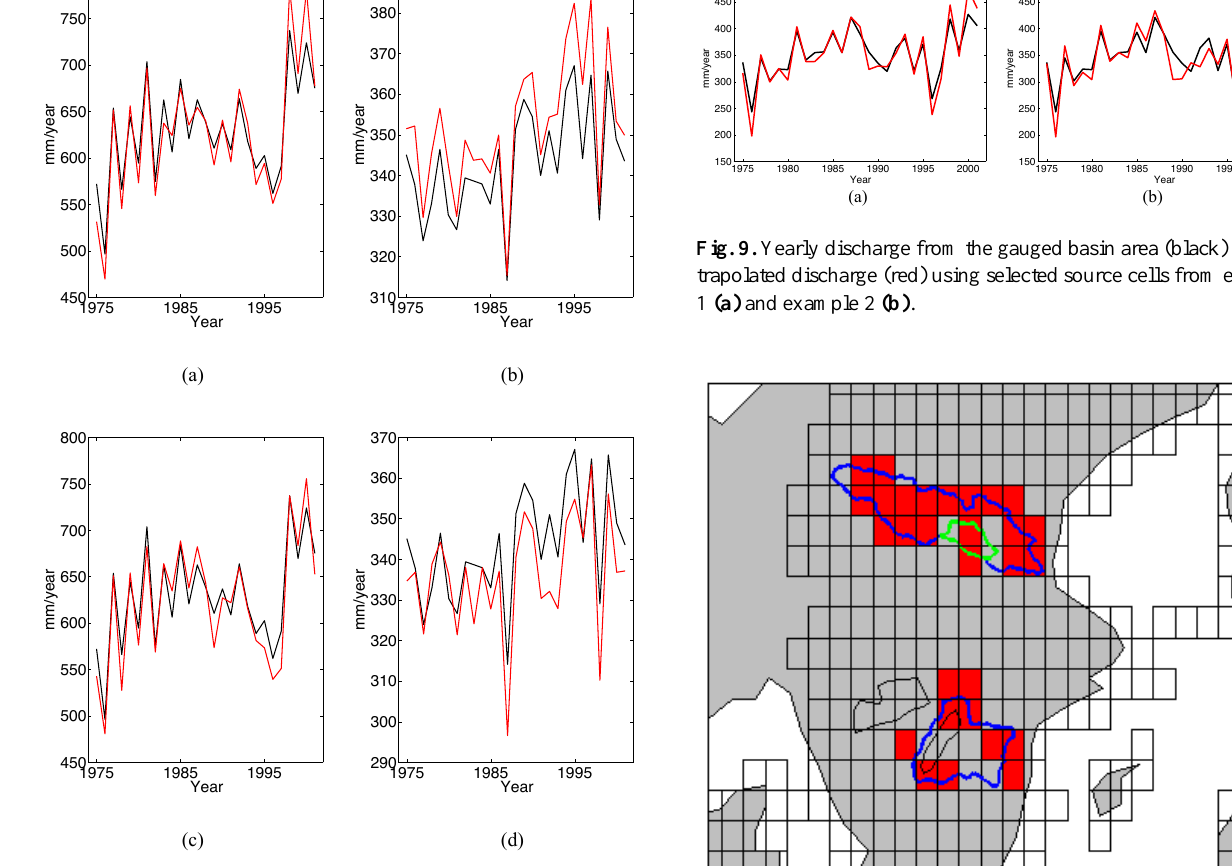
Fig. 8. Yearly precipitation (a) and potential evaporation (b) of the selected source cells (red) and of the entire gauged area (black) for 8a,b: Yearly precipitation (a) and potential evaporation from (b) of the selected source-cells 6 example 1 (Fig. 7a). Yearly precipitation (c) and potential evapora- (red) and of the entire gauged area (black) for example 1 (Figure 7a). 7 tion (d) of the selected source cells (red) and of the entire gauged area (black) for example 2 (Fig. 7b). 8c,d: Yearly precipitation (c) and potential evaporation from (d) of the selected source-cells 8 (red) and of the entire gauged area (black) for example 2 (Figure 7b). 9